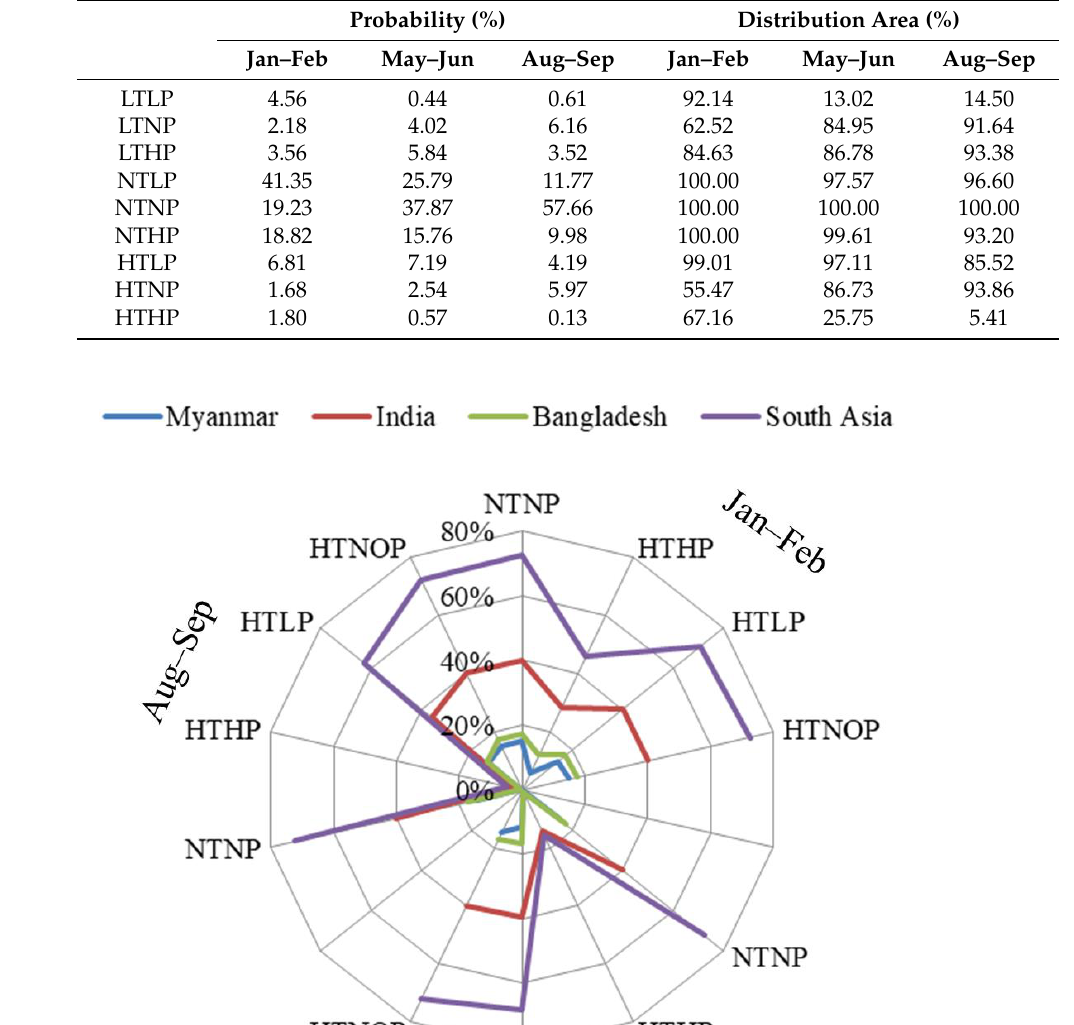
Table 3. During the 1982 – 2015 growing seasons, the probability of occurrence of various extreme meteorological events in the study area and the proportion of areas that experienced various extreme meteorological events.